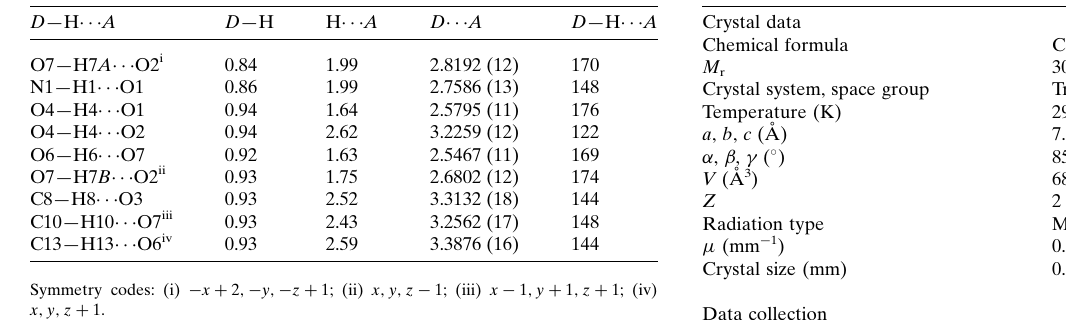
Table 1 Hydrogen-bond geometry (A˚ , (cid:5) ).